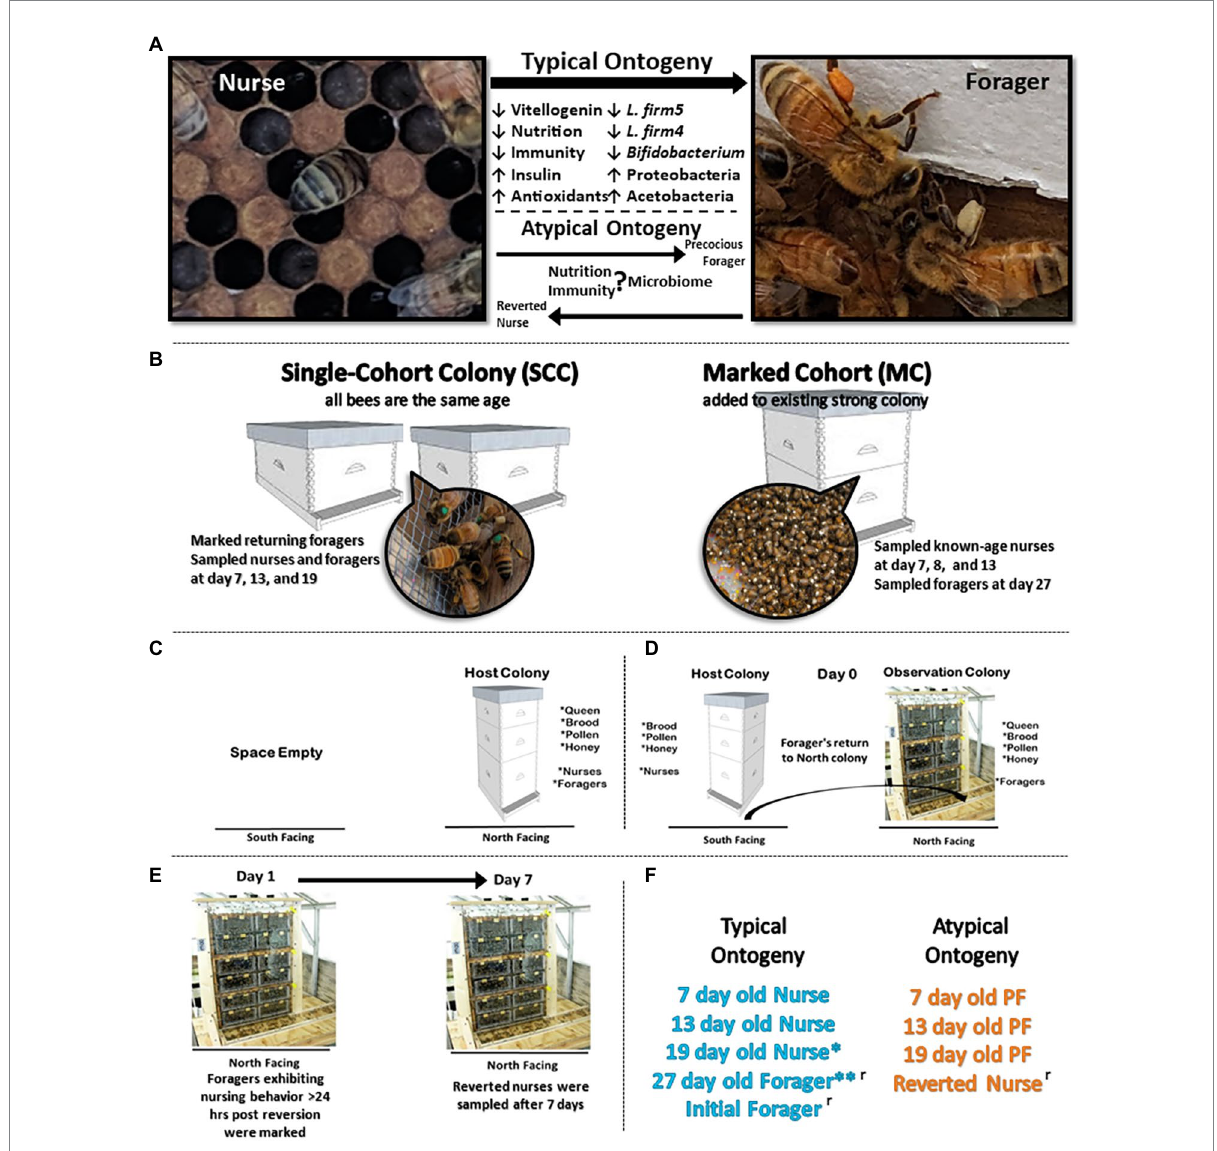
FIGURE 1 Experimental design. (A) During typical ontogeny workers transition from in-hive tasks like nursing to riskier outside the hive tasks like foraging as they age. We designed two experiments to explore this relationship of ontogeny, phenotypic plasticity, physiology, and the gut microbiota. (B) Experimental design for precocious forager experiment: to decouple age and behavioral task, we created two single-cohort colonies (SCC) with 4,500 and 3,500 bees. In a SCC, all bees are the same age but as an emergent property of sociality, some will differentiate by task into precocious foragers. We also established a marked cohort to sample normal age bees following classic ontogeny patterns. (C–E) Experimental design for reverted nurse experiment: a host colony was switched to an observation colony so that returning foragers returned to a colony with no nurses. By the same social mechanism, a proportion of old foragers will revert to nursing behaviors. (F) Typical (age-right and blue color) ontogeny occurs under normal colony demography. Atypical (orange color) designates a decoupling of age and behavior in response to colony needs. * 19 day old nurses can be considered as overage nurses, especially in a busy pollination season. These data present 19 are typical considering a long transition in-hive nursing before transitioning to foraging. ** 27 day old foragers were used in both experiments. ʳ designates categories used in reversion